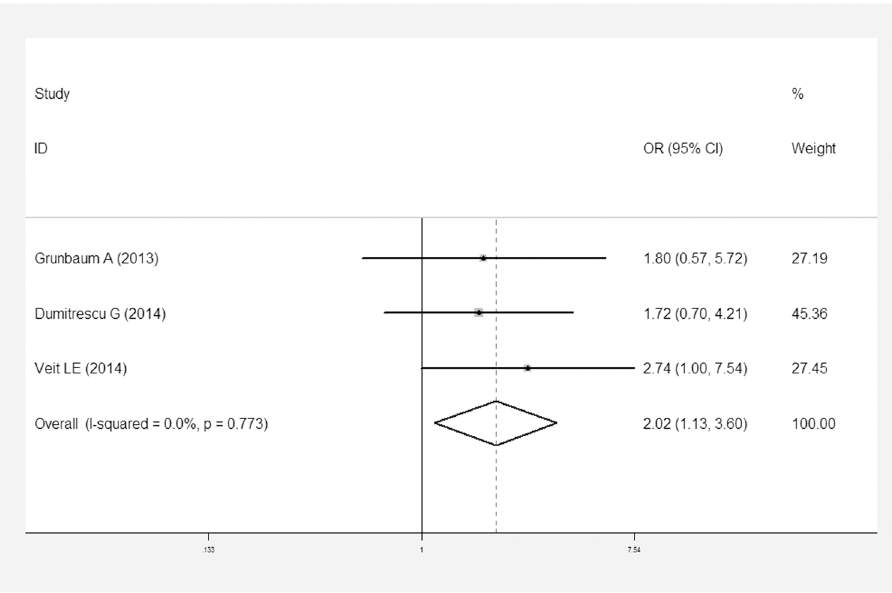
Fig 6. Meta-analysis of studies reporting dichotomous outcomes of 25(OH)D levels in UC patients vs. controls and estimated OR with a 95% confidence interval and weight percentage.